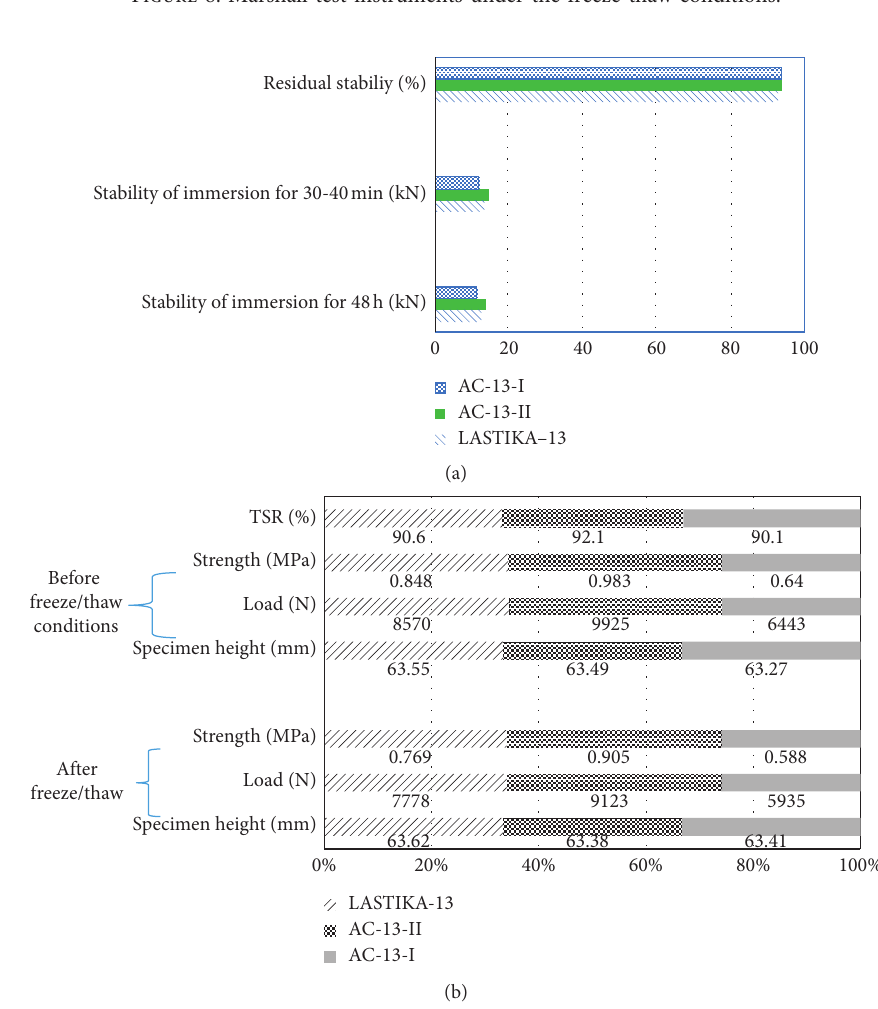
Figure 8: Marshall test instruments under the freeze-thaw conditions.